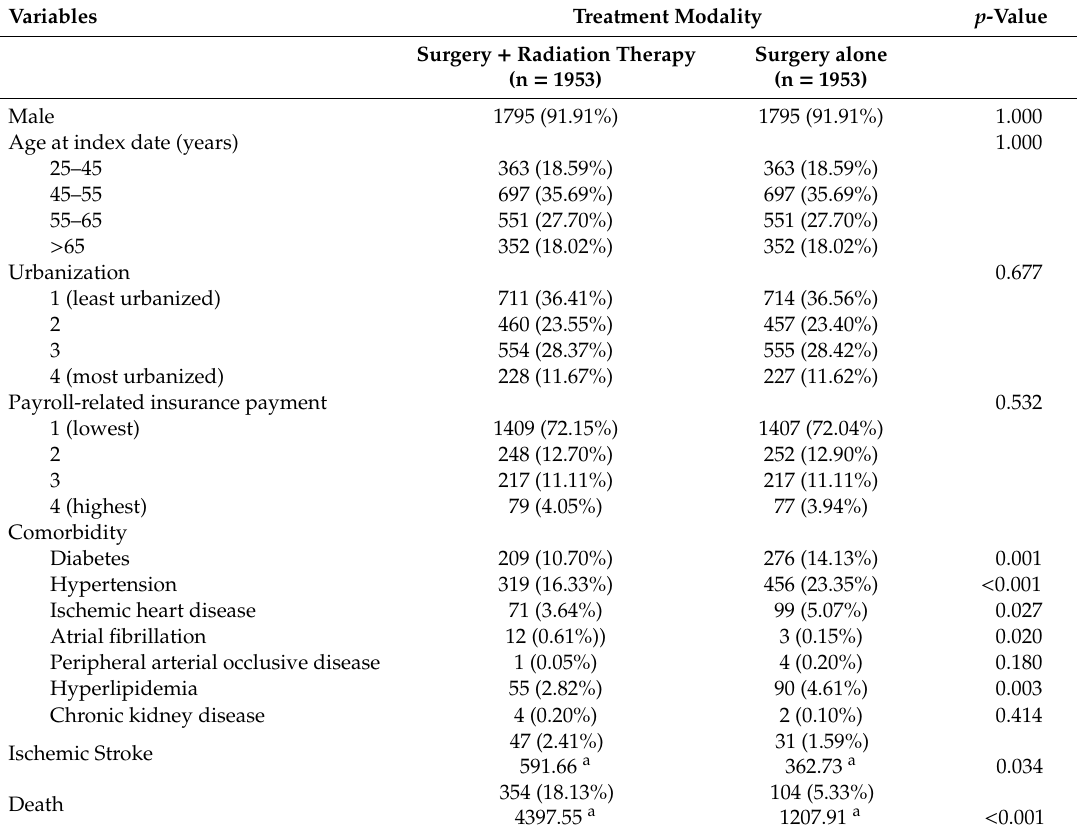
Table 3. Characteristics of the oral cavity survivors in 1:1 matching of those who received surgery with radiation therapy and those who received surgery alone.